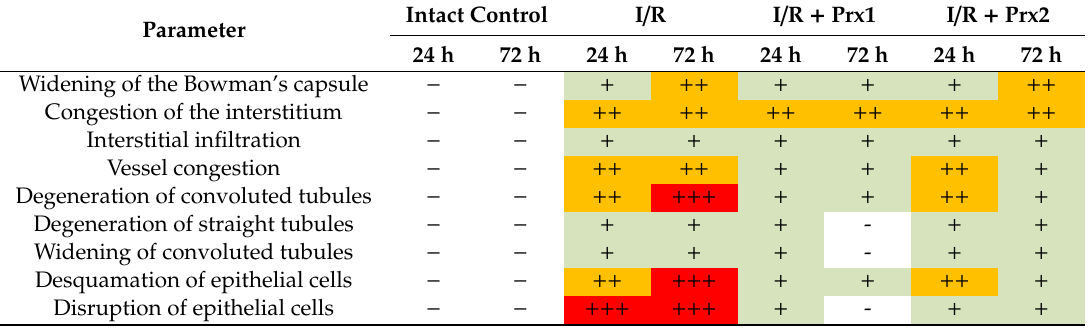
Table 3. Assessment of morphometric parameters of the kidney tissue after I / R and prior injection